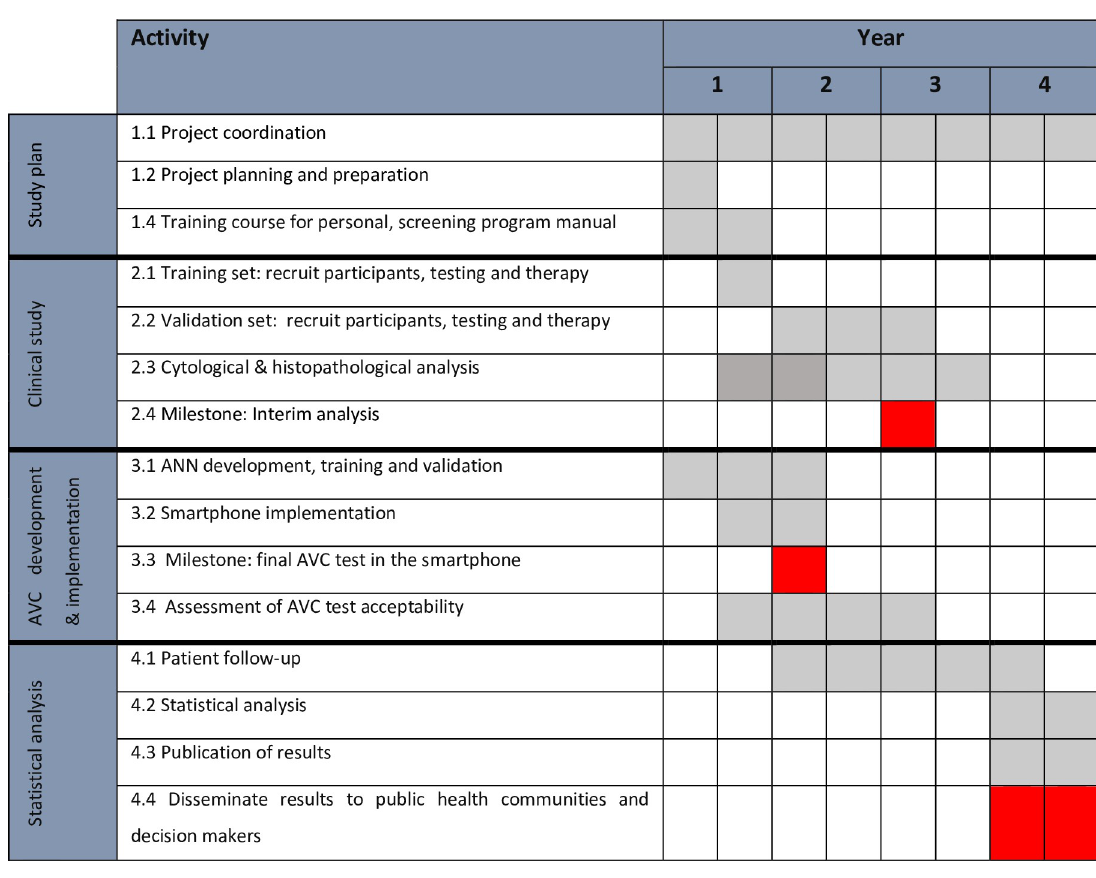
Fig 4. Project schedule and